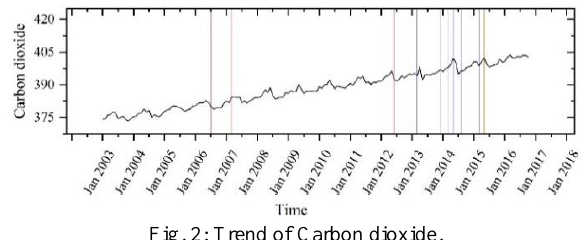
Fig. 2: Trend of Carbon dioxide.